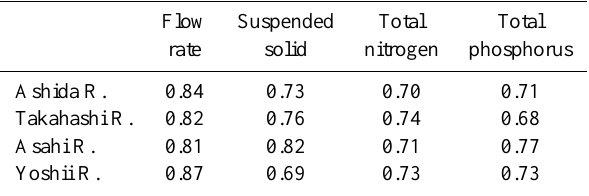
Table 2. The Nash–Sutcliffe index values for the validation